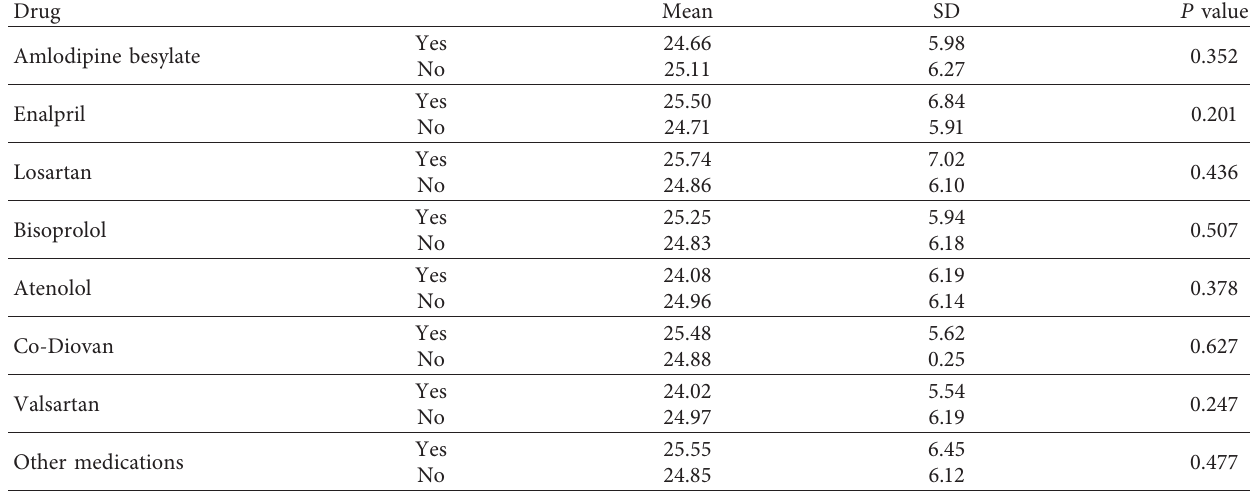
Table 8: Total score of the Hill-Bone CHBPTS according to the type of the antihypertensive drug.